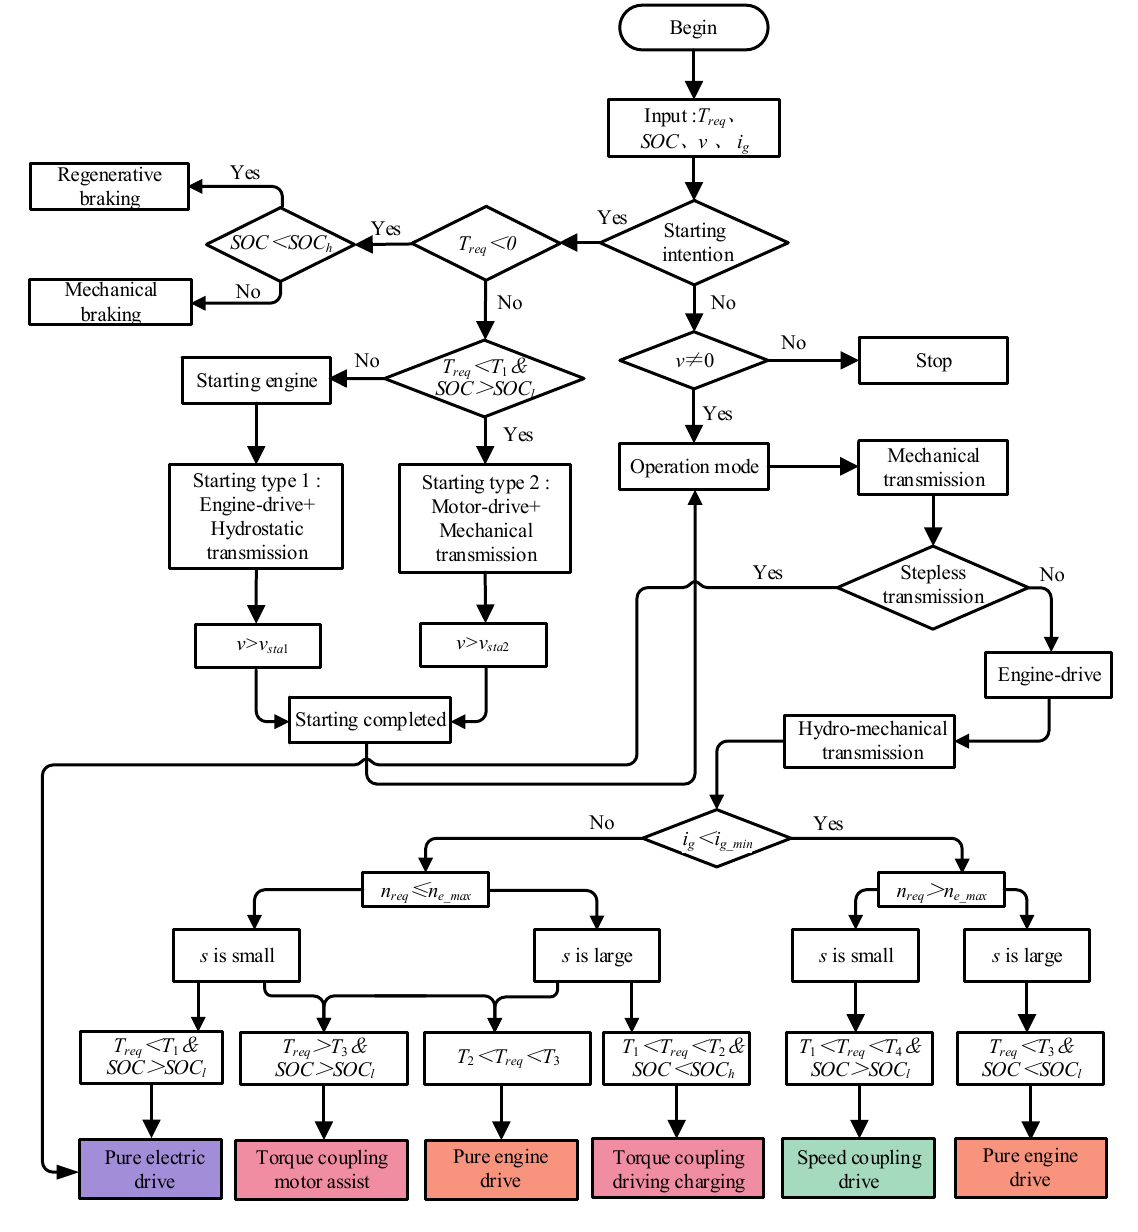
Figure 10. Rule-based MEH-PS workflow diagram.